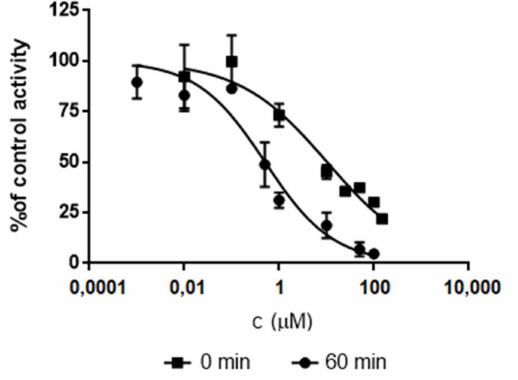
Figure 3. Inhibition curves (for β 5i activity) without and with 60-min pre-incubation of compound 10 demonstrate IC 50